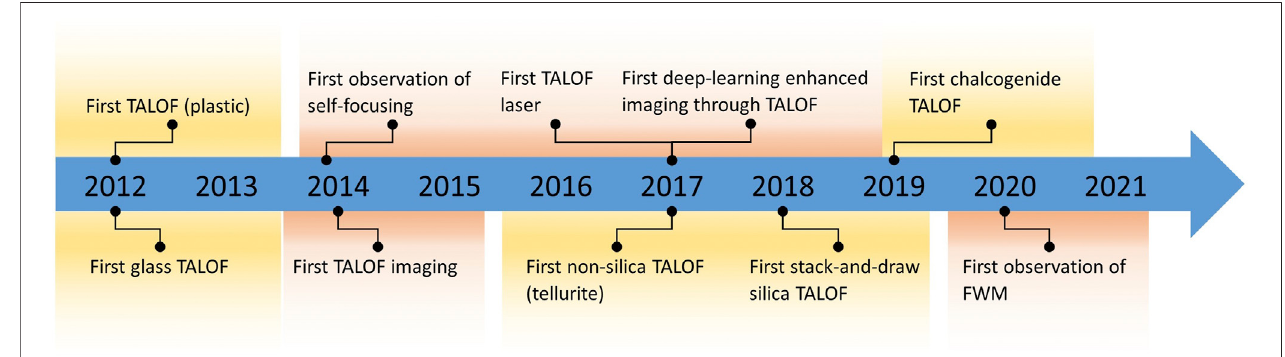
FIGURE 3 | Chronology of selected TALOF “ fi rsts ” including advances in materials (yellow) and applications (red).